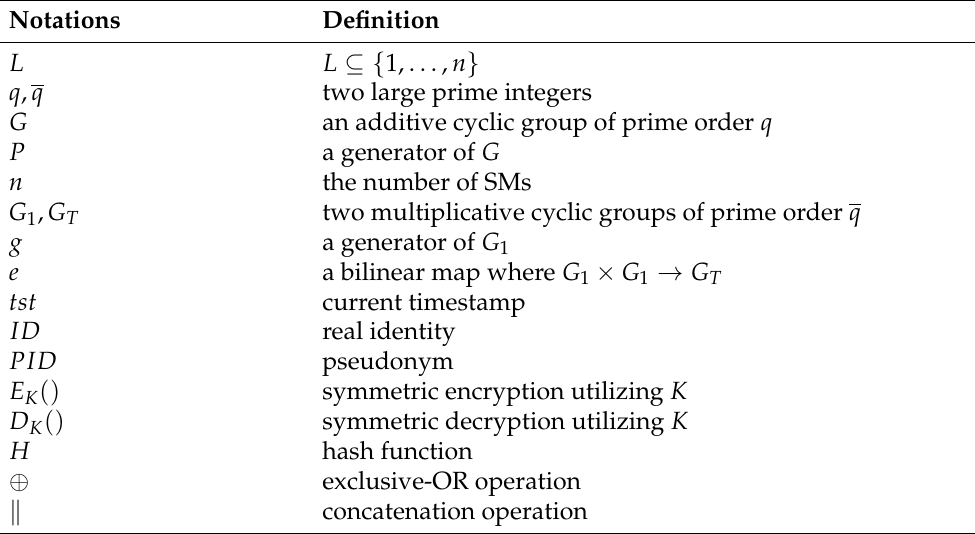
Table 2. Defintion of